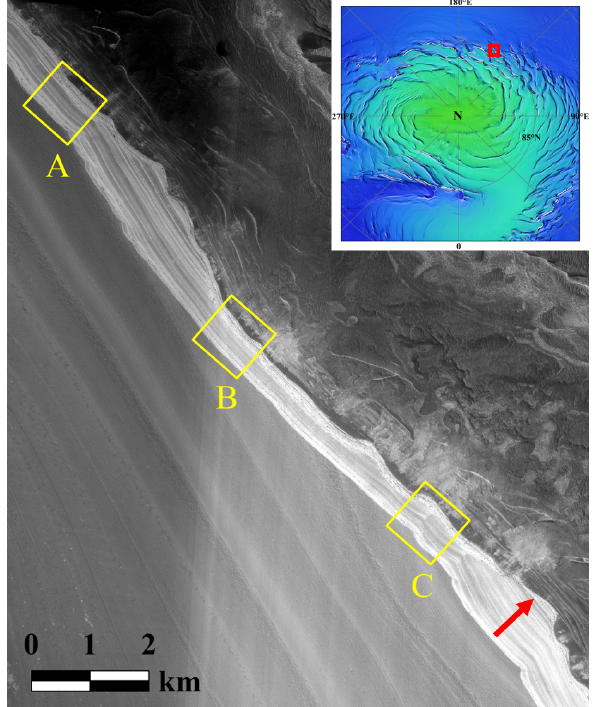
Figure 1. Red-filter HiRISE image ESP_018905_2650 at 85.0°N, 151.5°E. The red arrow points to the direction in which the slope descends. Three yellow boxes A, B, and C are the validation areas. The location of our study area is marked as a red box on the top right map, which is the Mars MGS MOLA Global Color Shaded Relief (Credit: USGS/NASA).